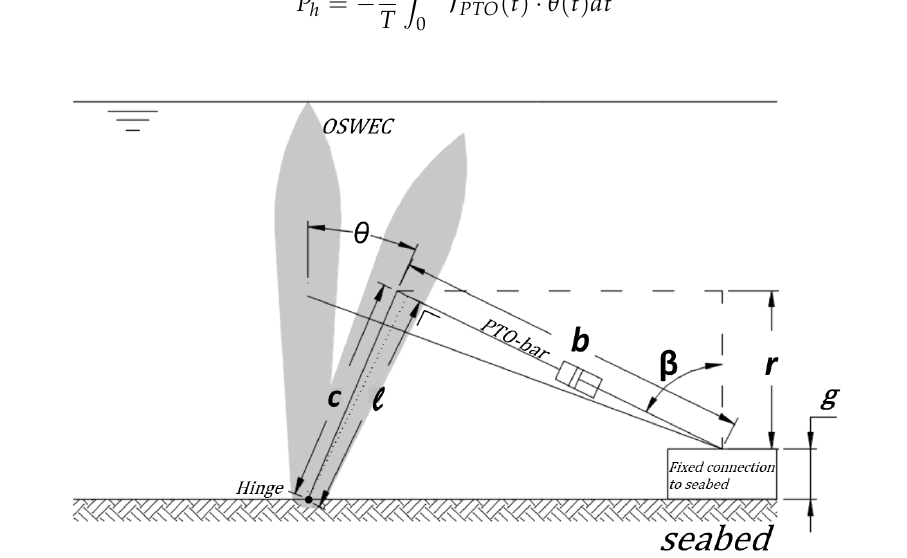
Figure 2. Hydraulic PTO system working principle of a generic